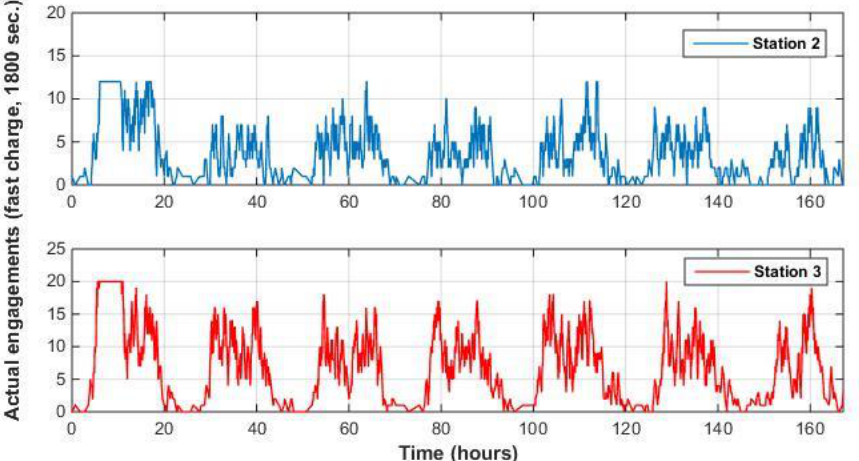
Figure 5. Engagement at the CPs of each CI for (0 12 20) CP distribution.